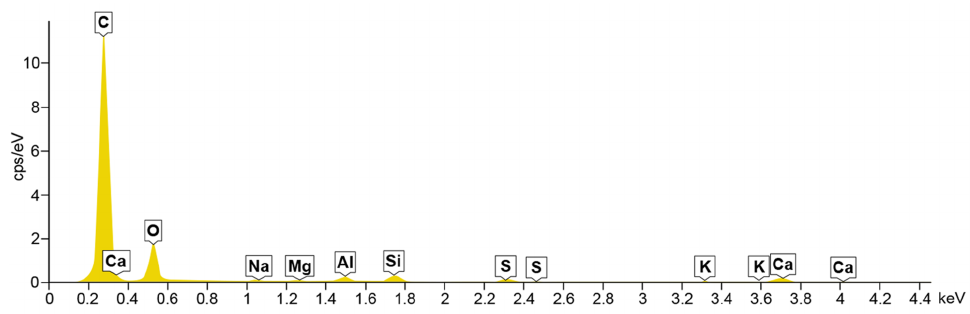
Figure 12. EDS for material M4.